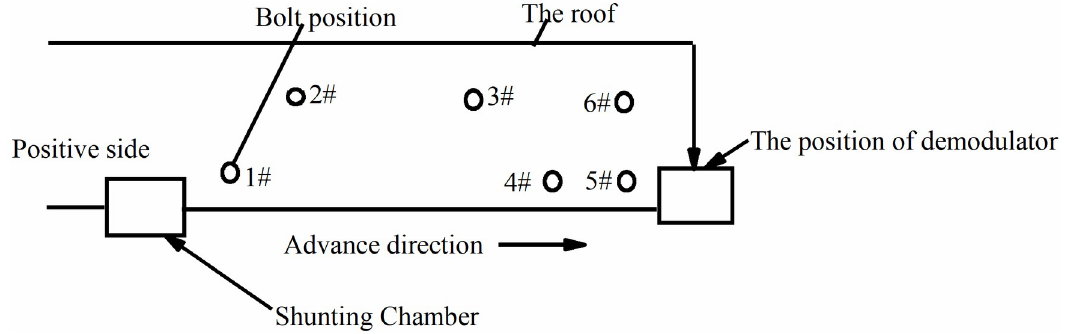
Fig 16. Position of bolt installation of positive side.